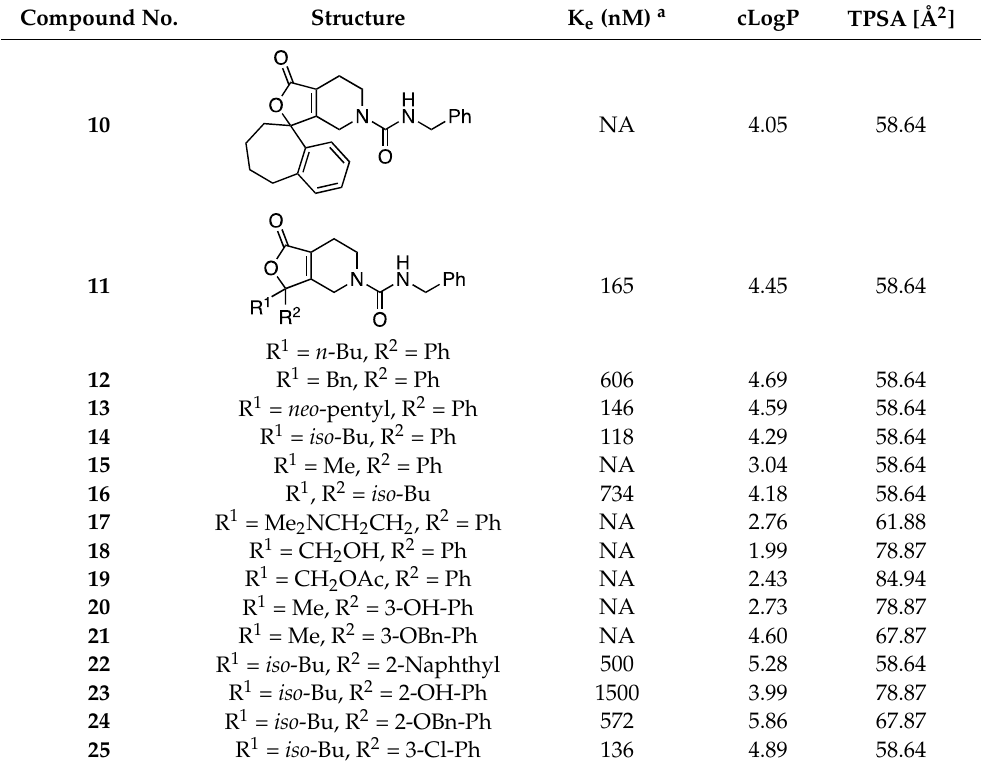
Figure 3. Compound 14b displays a right shift on agonist activity of NPS in calcium mobilization assay (Ke). Table 3. Modifications of urea portion of lead compound 14. Compound No.